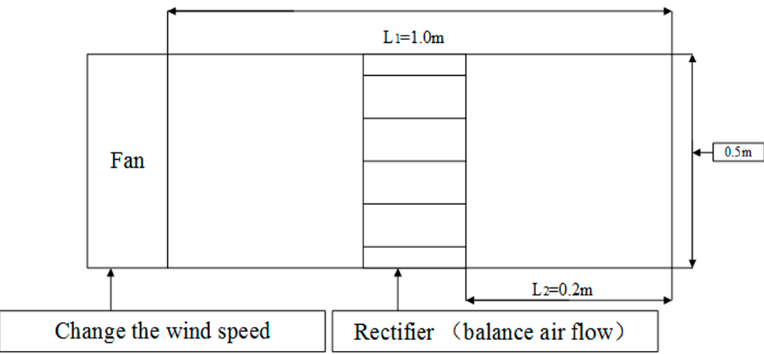
Figure 12. Schematic diagram of the rectifier.